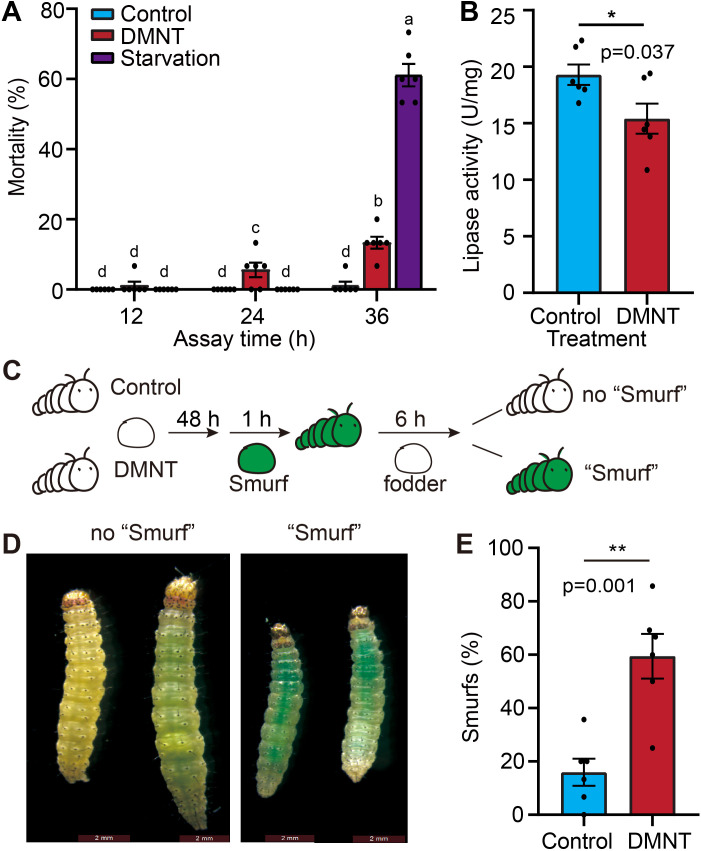
The midgut barrier of P. xylostella larvae is damaged by (3E)-4,8-dimethyl-1,3,7-nonatriene (DMNT) treatment.(A) Larvae die earlier from treatment with DMNT than from starvation. (B) Decreased lipase activity in the midgut of P. xylostella larvae upon DMNT treatment. (C) The principle of the Smurf test. Larvae are fed with forage loaded with the dye erioglaucine disodium salt for 1 hr before returning to normal forage without dye. After 6 hr, the extent of dye retention is monitored. (D) Representative images of DMNT-treated larvae showing dye retention, as evidenced by their blue appearance, like the Smurf cartoon character. (E) Quantification of results shown in (D). The different letters in (A) indicate a significant difference (one-way ANOVA). Error bars in (B, E) represent the standard error of six independent biological replicates, with 15 larvae per replicate. Asterisks in (B, E) indicate significant differences (*p<0.05, **p<0.01, ns, not significant; two-tailed unpaired t-test).
Figure 2—source data 1.The midgut barrier of P. xylostella larvae is damaged by (3E)-4,8-dimethyl-1,3,7-nonatriene (DMNT) treatment.